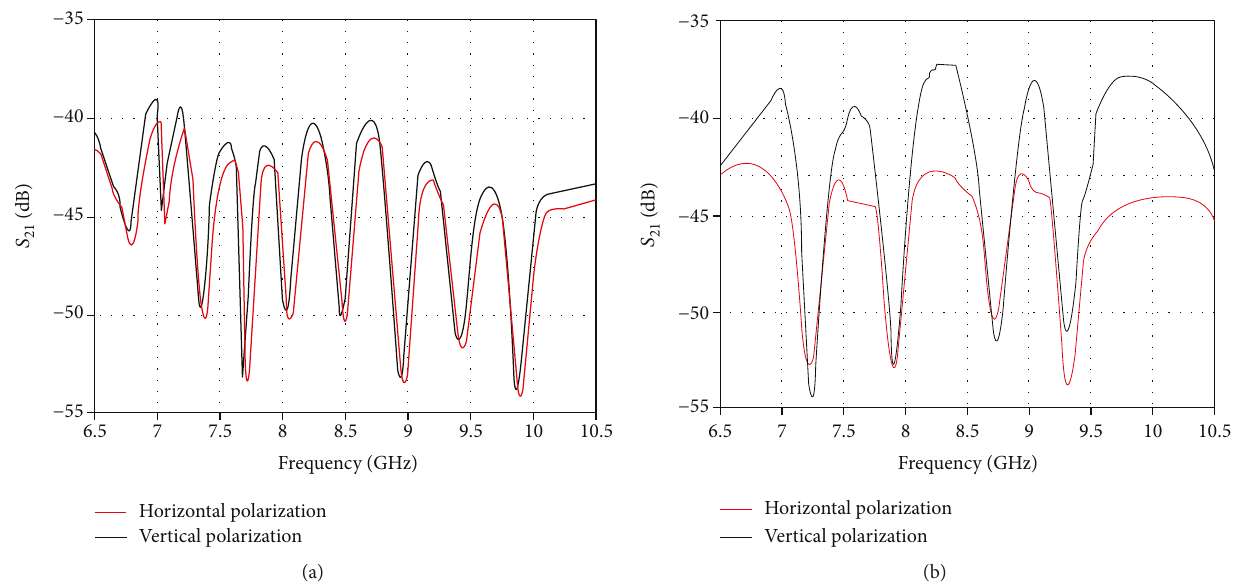
Figure 4: Tag-measured response under horizontal and vertical excitation for (a) code 111111111 and (b) code 010101010.